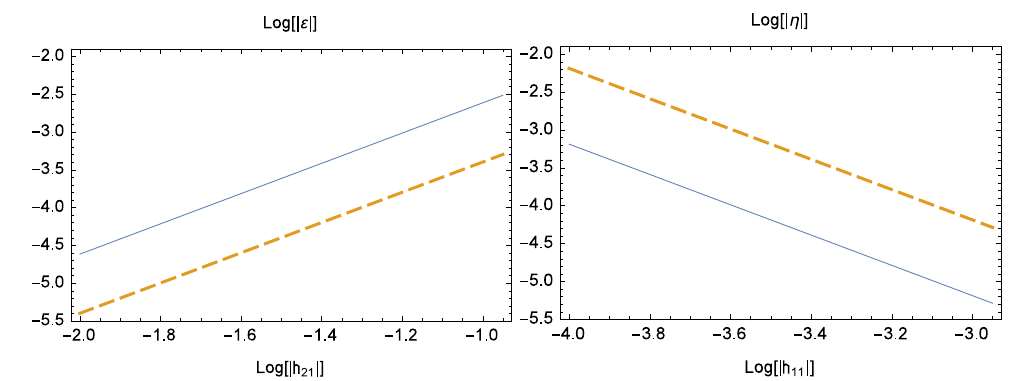
Figure 1. ( Left ) Logarithm (base 10) of the absolute value of the CP asymmetry | ε | as a function of logarithm (base 10) of | h 21 | for M 2 = 1.2 · M 1 (solid line) and M 2 = 10 · M 1 (dashed line). ( Right ) Logarithm (base 10) of the absolute value of the efficiency factor | η | as a function of logarithm (base 10) of | h 11 | for M 1 = 100TeV (solid line) and M 1 = 1000TeV (dashed line). Here we fix | h 12 | = | h 31 | = 0 and ∆ ϕ 21 = π